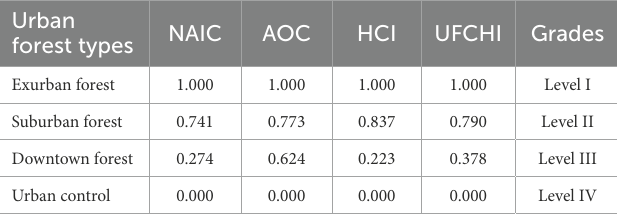
TABLE 6 Indicators’ normalized value of the whole year and their UFCHI. Urban forest